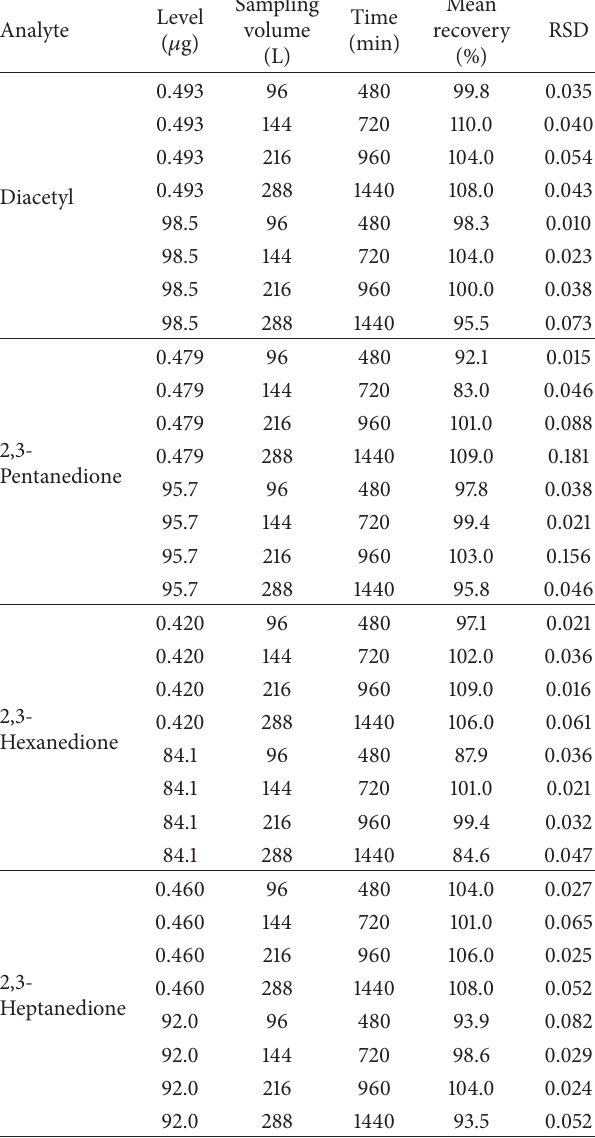
Table 10: Determination of extended air sampling capacity of o - PDA-treated silica gel tubes at 20% relative humidity at 2 concen- tration levels using increased sampling rate (200